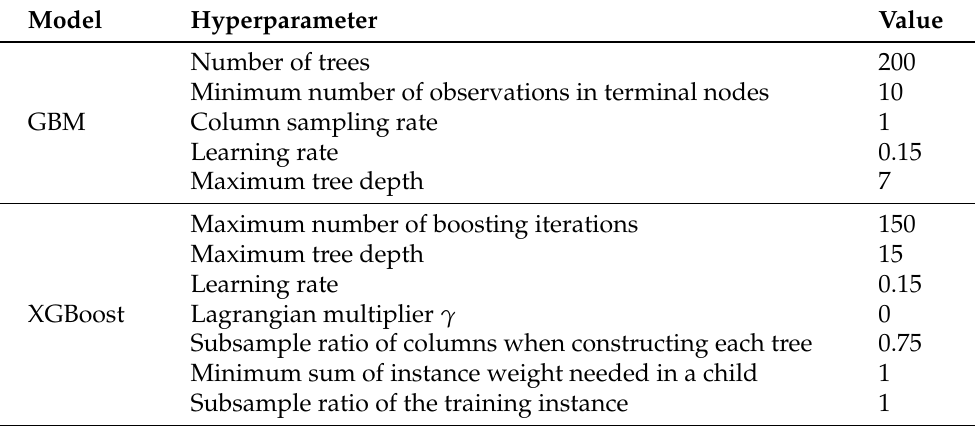
Table 3. Final hyperparameter configurations of GBM and XGBoost